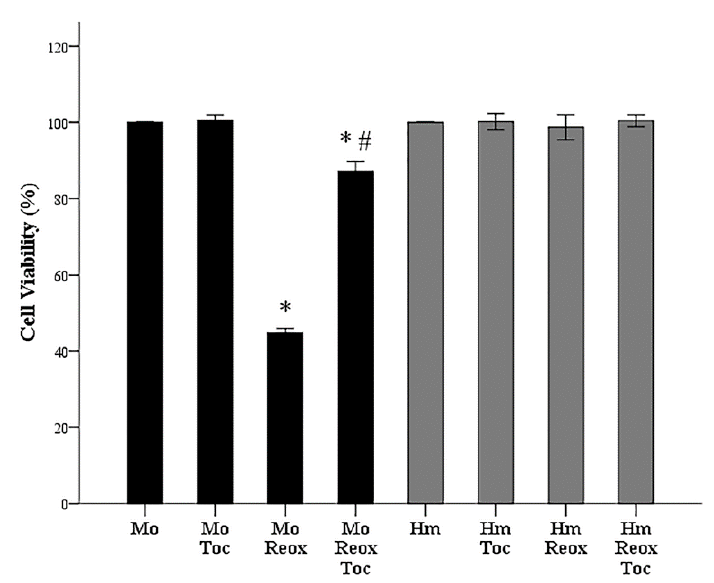
Figure 2. Cell survival due to warm anoxia-reoxygenation and the effect of α -tocopherol. The XTT assay revealed that cell survival in mouse RPTECs was decreased in contrast to hamster RPTECs that well tolerated 24 h of anoxia followed by 2 h of reoxygenation. The presence of α -tocopherol (Toc) did not affect the cell viability of hamster RPTECs. However, it significantly enhanced cell viability of mouse RPTECs subjected to anoxia-reoxygenation. These experiments were repeated nine times in triplicate. Error bars correspond to SEM, the asterisk (*) to p < 0.001 when compared to the respective control cells, and the hashtag (#) to p < 0.001 between cells subjected to anoxia-reoxygenation without or with α -tocopherol. Mo stands for mouse, Hm for hamster, ctrl for control, Reox for reoxygenation, and Toc for α -tocopherol.